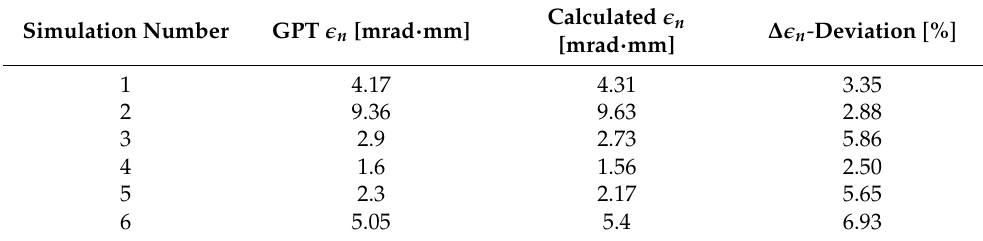
Table 1. Simulations’ results and deviations.